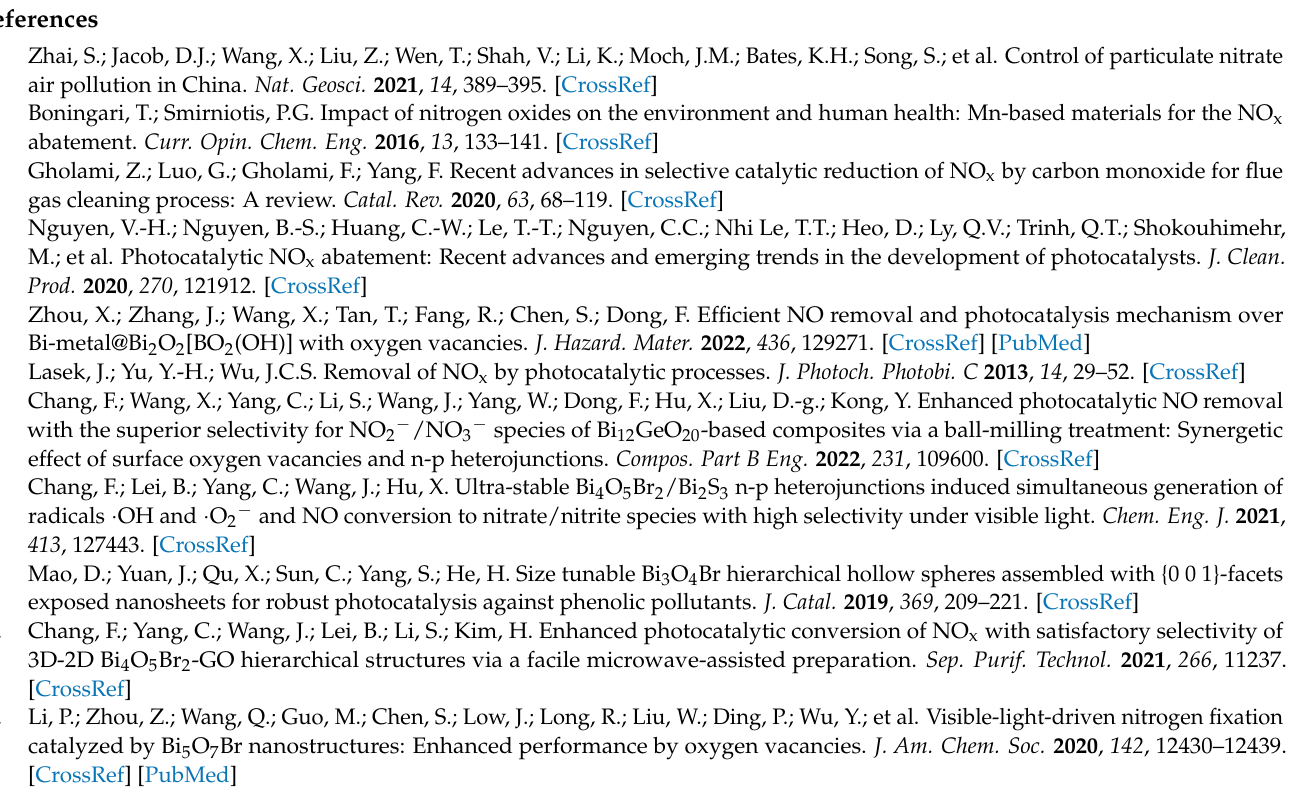
(b); Figure S7: PL spectra of BOB, PB5, and BPO; Figure S8: Full-scan XPS spectra of PB5 before and after reaction; Figure S9: TEM (a) and HRTEM (b) images of composite PB5 after five cycles;